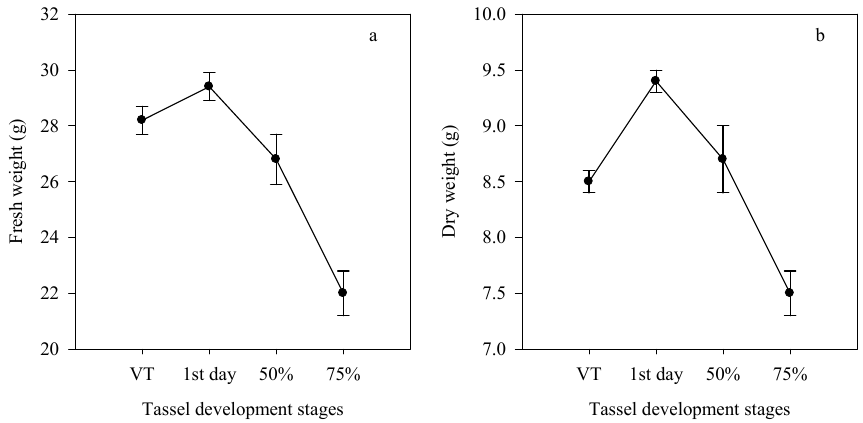
Figure 3. Effect of corn tassel development stages on tassel fresh weight ( a ) and tassel dry weight ( b ). Corn varieties had significantly different ( p ≤ 0.01) tassel fresh weights. Hibrix3 had the highest tassel fresh weight (31.2 g) followed by Sugar75 and KGW1 (29.2 and 28.8 g, respectively) (Table 3).